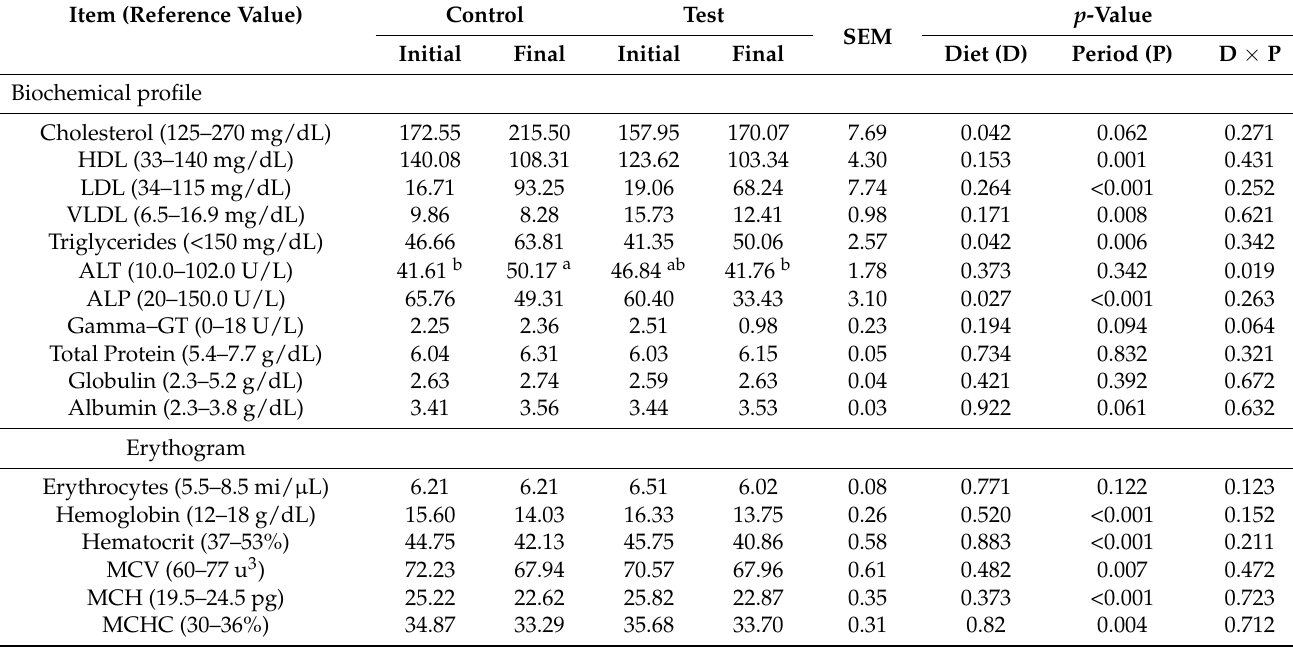
Table 3. Means of blood variables of dogs fed diets containing choline chloride (control) or the herbal source of choline (test) at the beginning and end of the